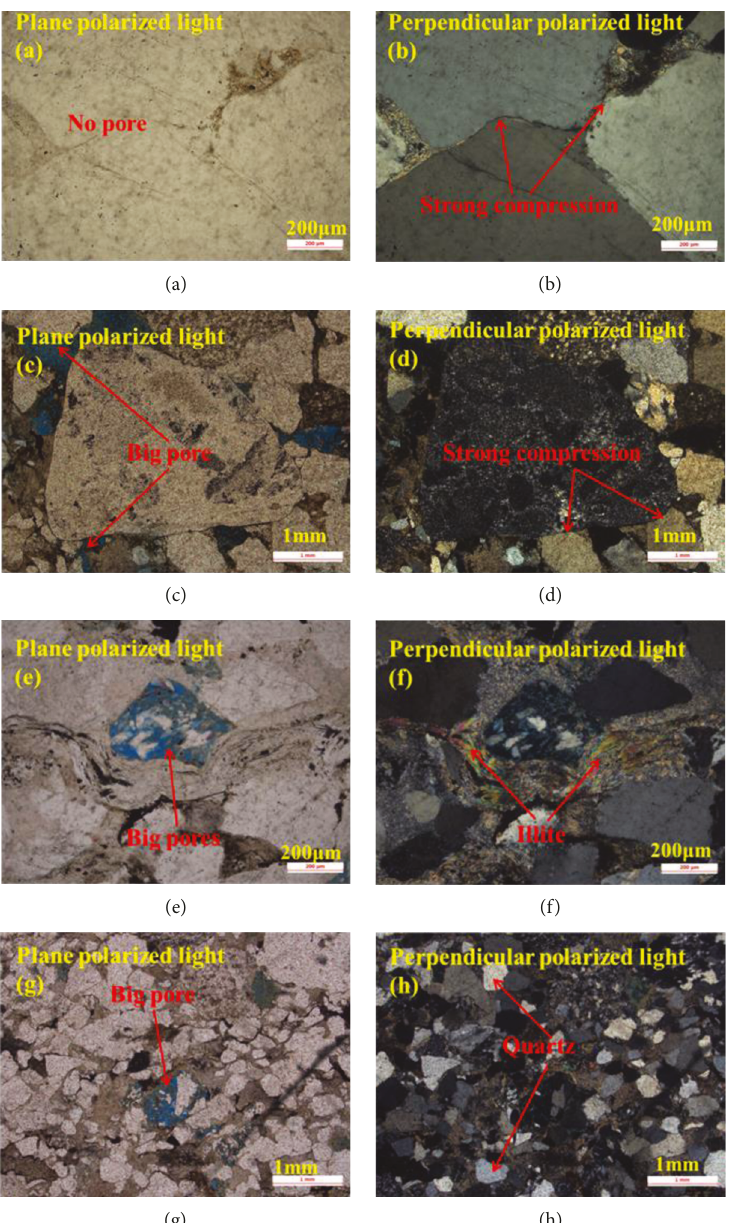
Figure 6: The casting thin section: (a) – (e) belong to S20-5 and (f) – (h) belong to S96-3. The left picture and the right picture belong to the same